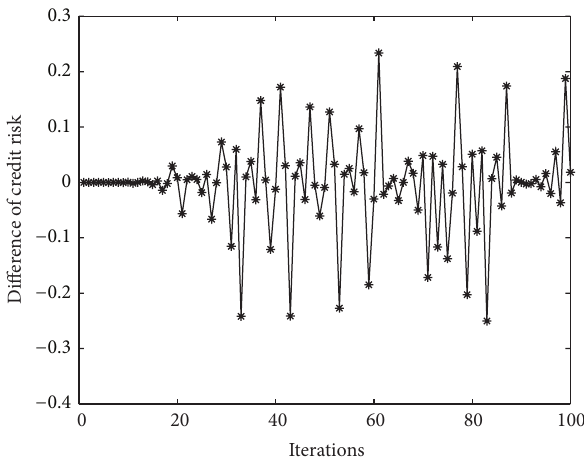
Figure 6: Sensitivity of the credit risk to the initial